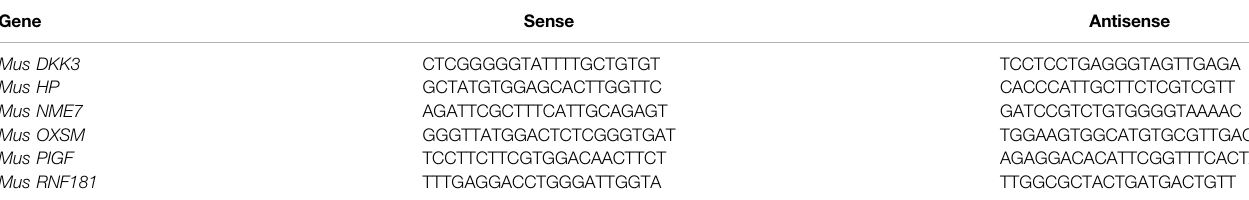
TABLE 1 | Primer sequences for qRT-PCR analysis